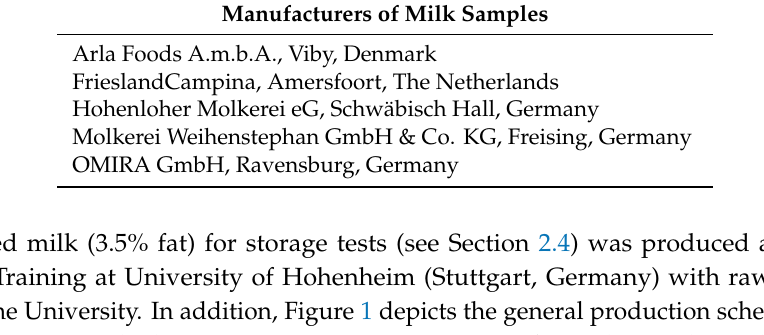
Table 1. Manufacturer of commercial milk samples in alphabetical order. Manufacturers of Milk